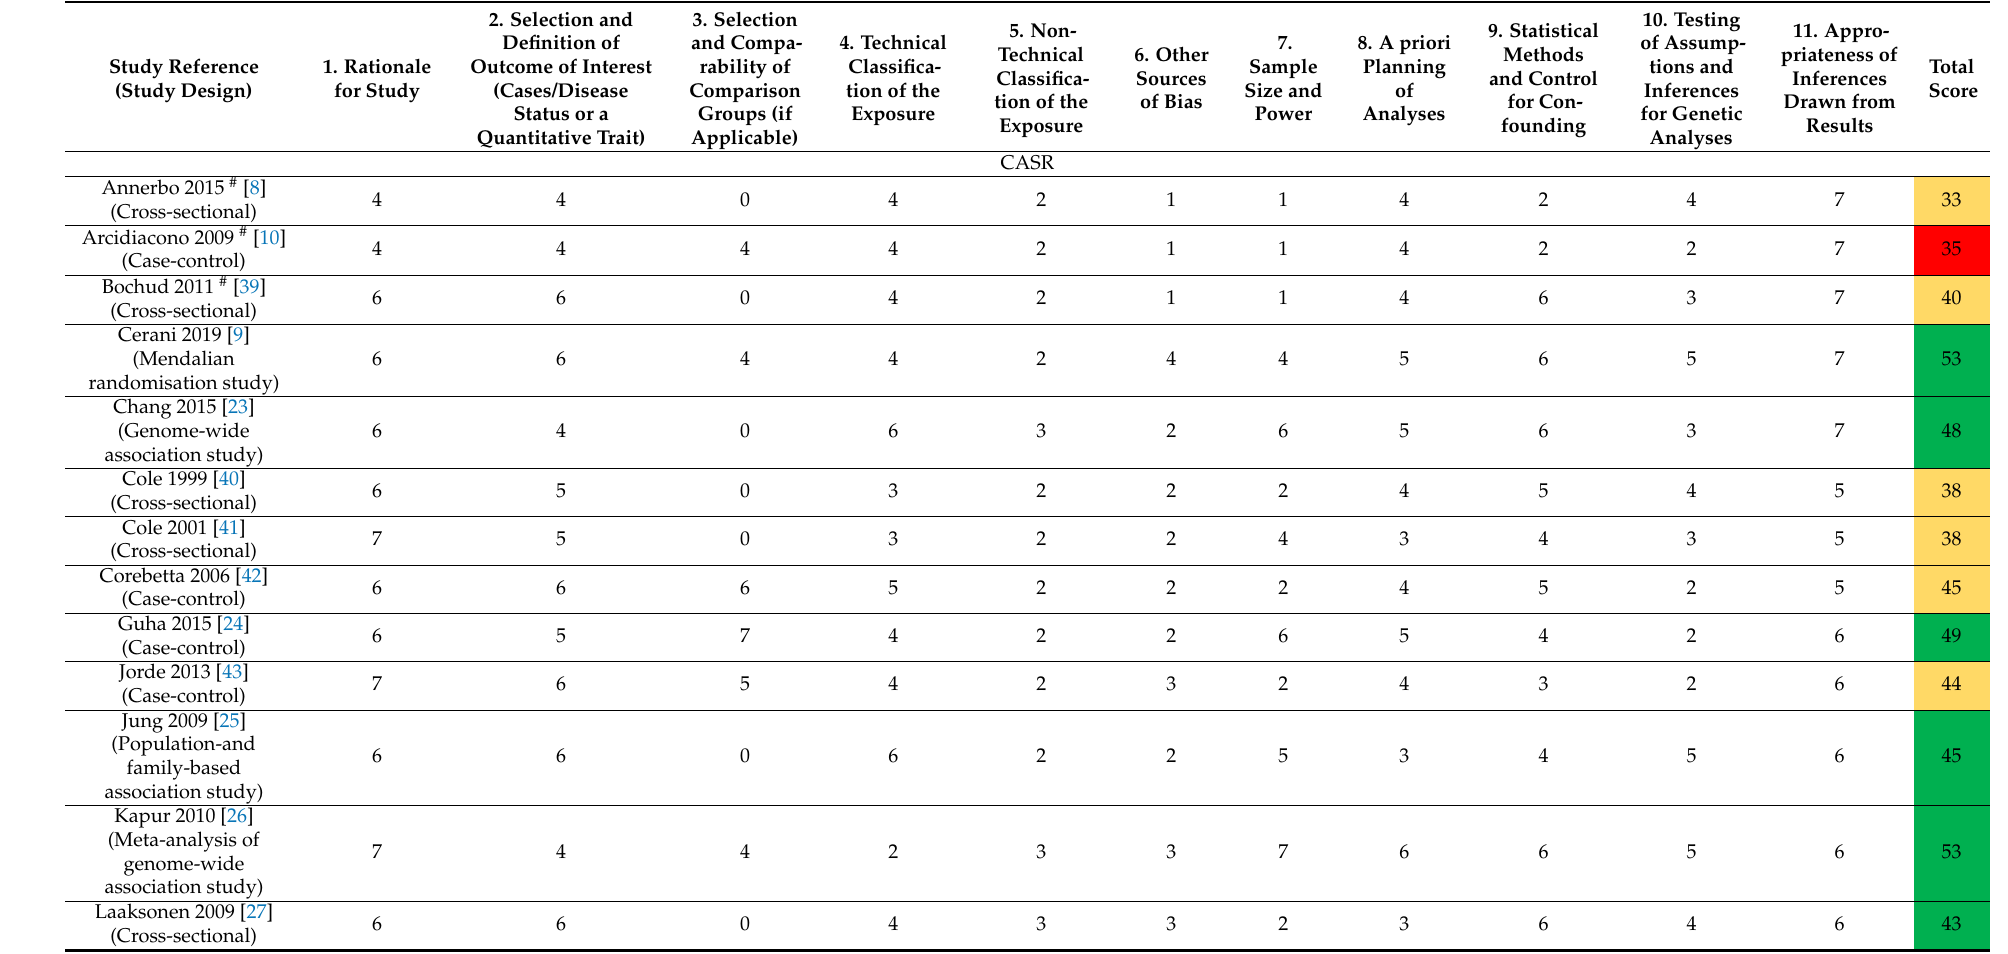
Table 1. Risk of bias assessment using the Q-Genie